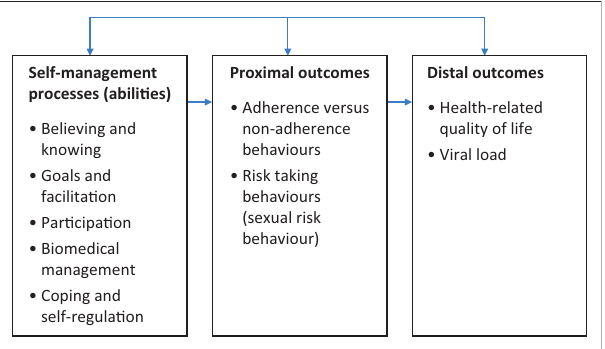
FIGURE 2: Conceptual framework based on the individual and family self- management theory.